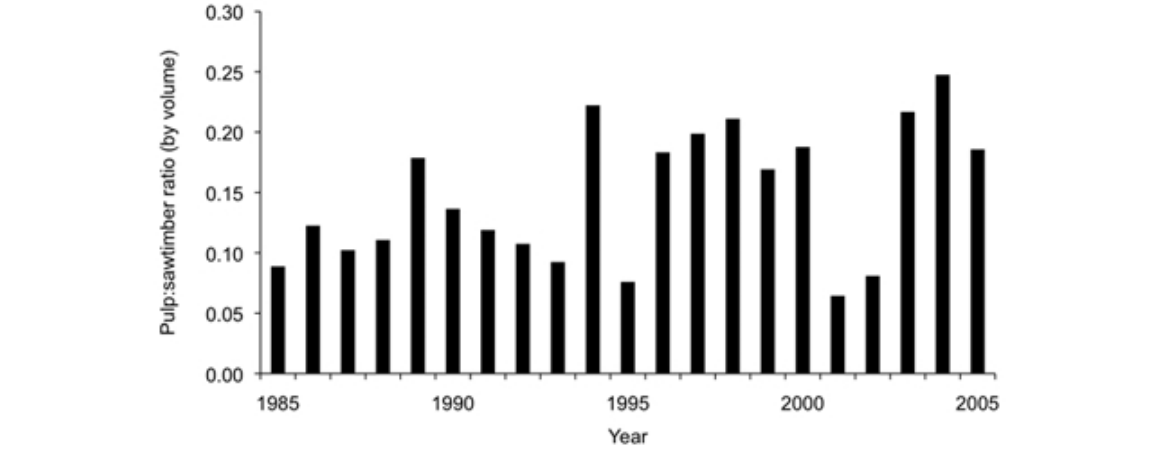
Fig. 6 . Ratio (based on volume) of pulp grade to saw grade materials offered in Tongass National Forest timber sales from